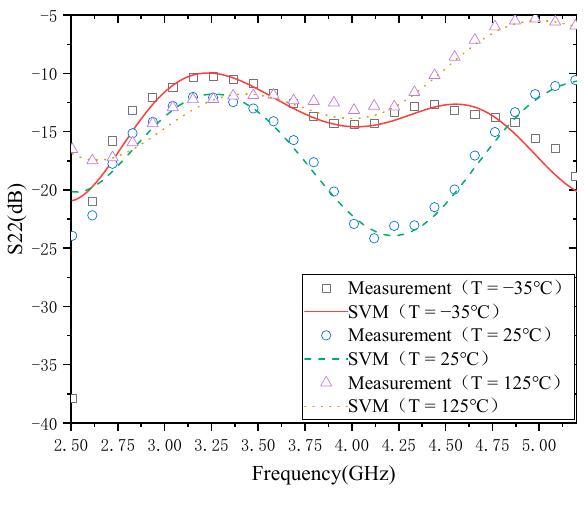
Figure 7. Modeling results of S22.